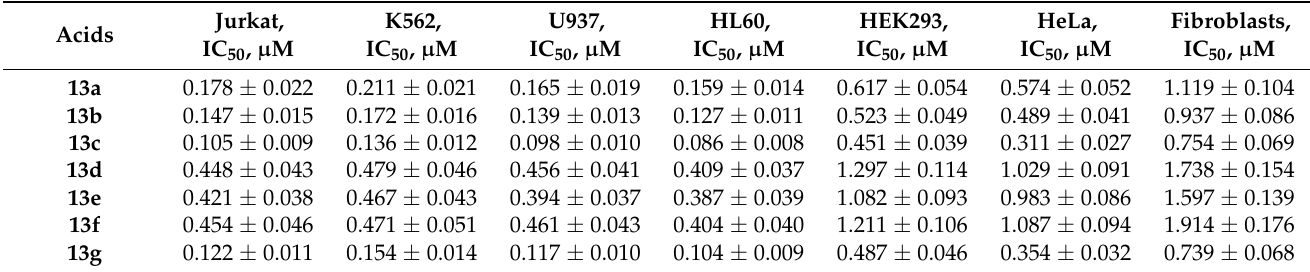
Table 1. Cytotoxic activity in vitro of trienoic acids 13a – g (48 h). Acids